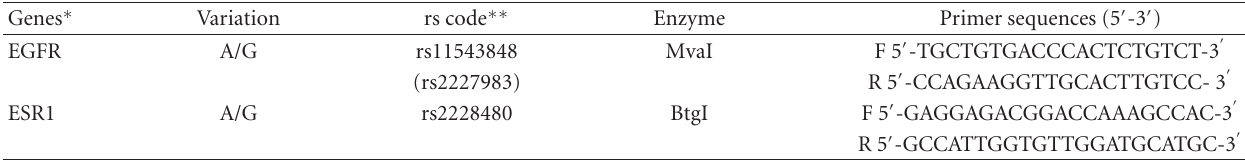
Table 1: Position of SNP and enzyme and primers used in this